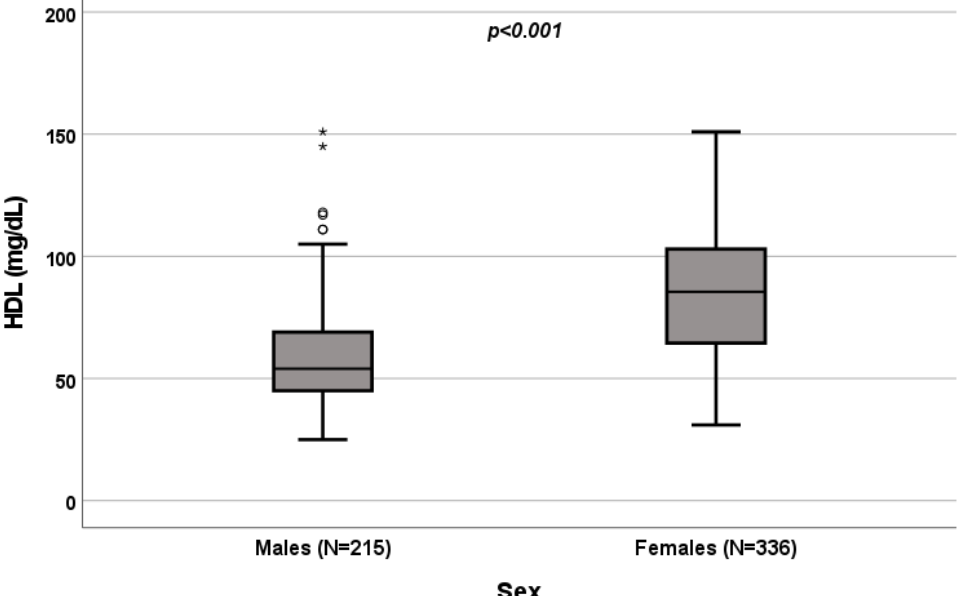
Figure 2. Influence of sex on HDL levels (mg/dL). Box plot of sex’s influence on HDL levels (mg/dL): The black lines in the boxes show the interquartile ranges (IQRs): quartile 1, median values and quartile 3; the open dots and stars describe the outlier values. Symbols (star and circle) indicate outliers of the study sample. The p -value is shown.